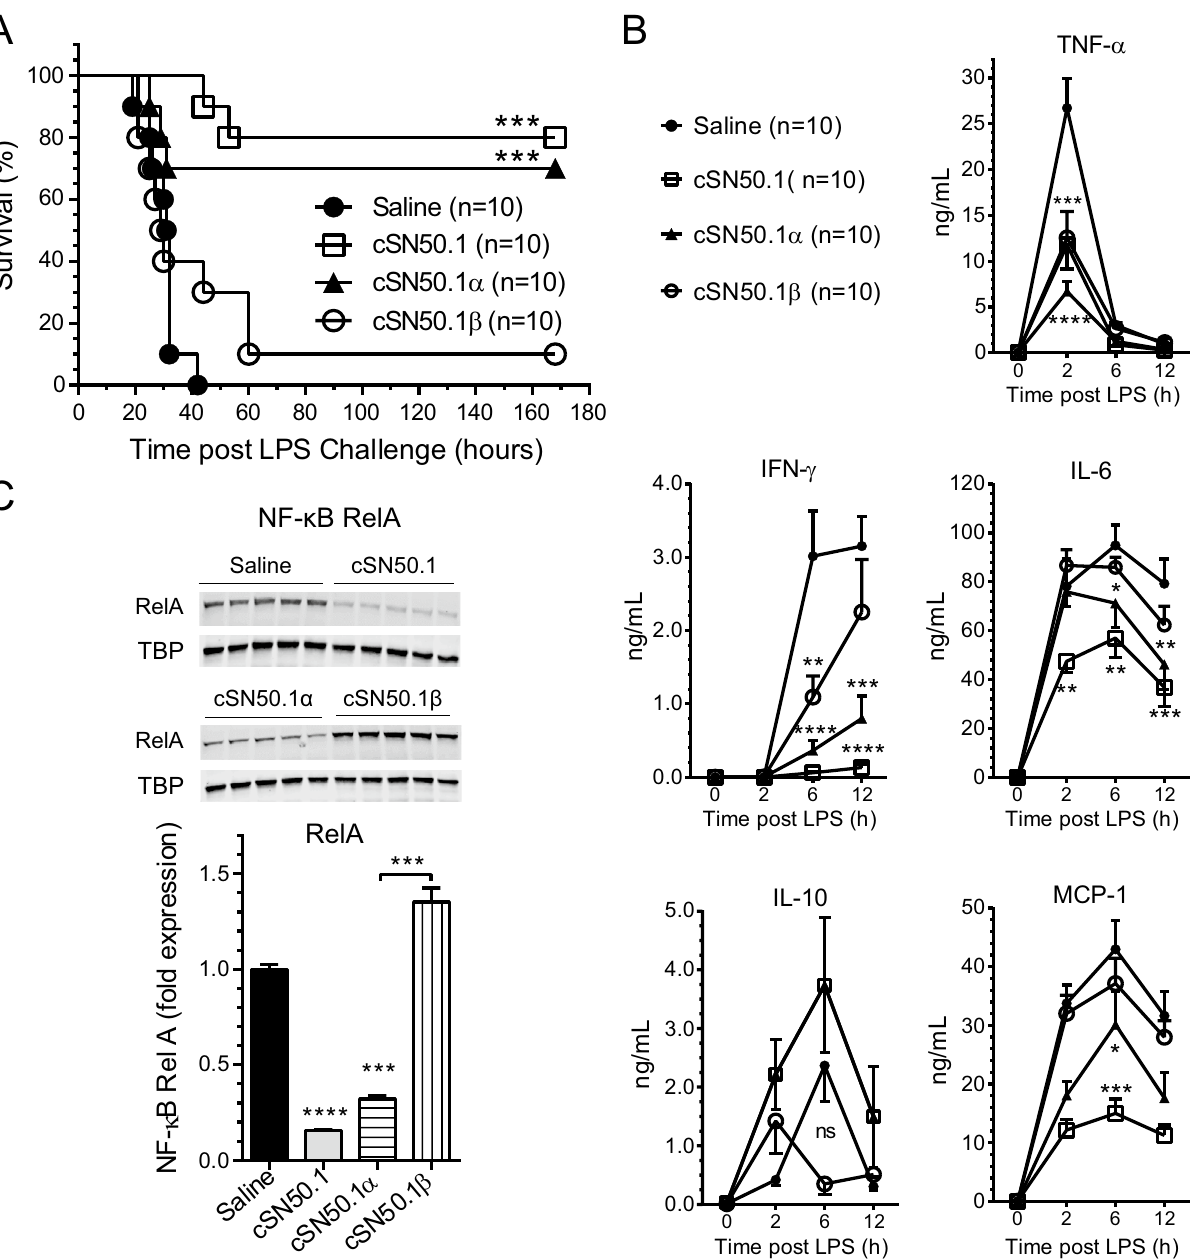
Figure 6. Short-term treatment of LPS-induced lethal microbial inflammation in hyperlipidemic mice with biselective and Imp α5-selective NTMs is effective while Imp β1-selective NTM is ineffective. ldlr −/− female mice were treated according to the short-term treatment protocol (see Fig. 3B). Briefly, 15-week-old female mice fed with HFD for three weeks were challenged with non-lethal dose of LPS (IP, 10 μg/g in 0.2 mL saline) followed by treatment with 15 doses of saline (control; IP, 0.2 mL), biselective NTM, cSN50.1 peptide, or monoselective NTMs, cSN50.1α or cSN50.1β peptides (33 μg/g/injection in 0.2 mL saline) administered 30 min before LPS challenge and over 3 days thereafter. ( A ) Mice treated with biselective, and Imp α5-selective NTMs display 80% and 70% survival, respectively. Treatment with Imp β1-selective NTMs did not protect the majority of hyperlipidemic mice from death caused by LPS-induced microbial inflammation (10% survival). Data is presented as Kaplan–Meier survival plot with p value calculated by log rank analysis, ** p < 0.005, *** p < 0.0005. ( B ) Cytokines (TNF-α, IFN-γ, IL-6, and IL-10) and chemokine MCP- 1, levels were determined in blood plasma collected from saphenous vein of animals before and 2, 6, and 12 h after LPS challenge. Data is presented as a mean ± SEM (n = 10). Statistical significance was determined by repeated measures two-way ANOVA analysis of variance with Holm-Sidak test for multiple comparison, * p < 0.05, ** p < 0.005, *** p < 0.0005, **** p < 0.0001. ( C ) Nuclear translocation of SRTFs NF-κB RelA was determined by quantitative immunoblotting of liver nuclear extracts obtained at the time of sacrifice. Western blots were analyzed using LI-COR Odyssey Infrared Imaging System (unedited full-length immunoblots are presented in Supplementary Figure S5B). Data is presented as a mean ± SEM (n = 10). Statistical significance was determined by ordinary one-way ANOVA with Holm–Sidak test for multiple comparison, *** p < 0.0005, **** p <